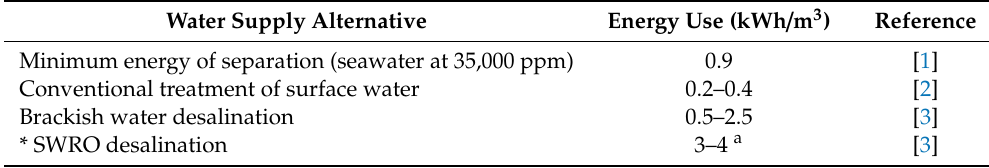
Table 1. Energy used for di ff erent feed